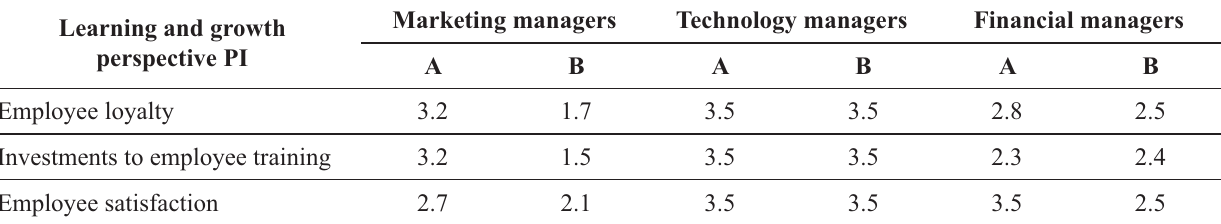
Table 5. Learning and growth perspective PI usage by managers of companies A and B (mean)